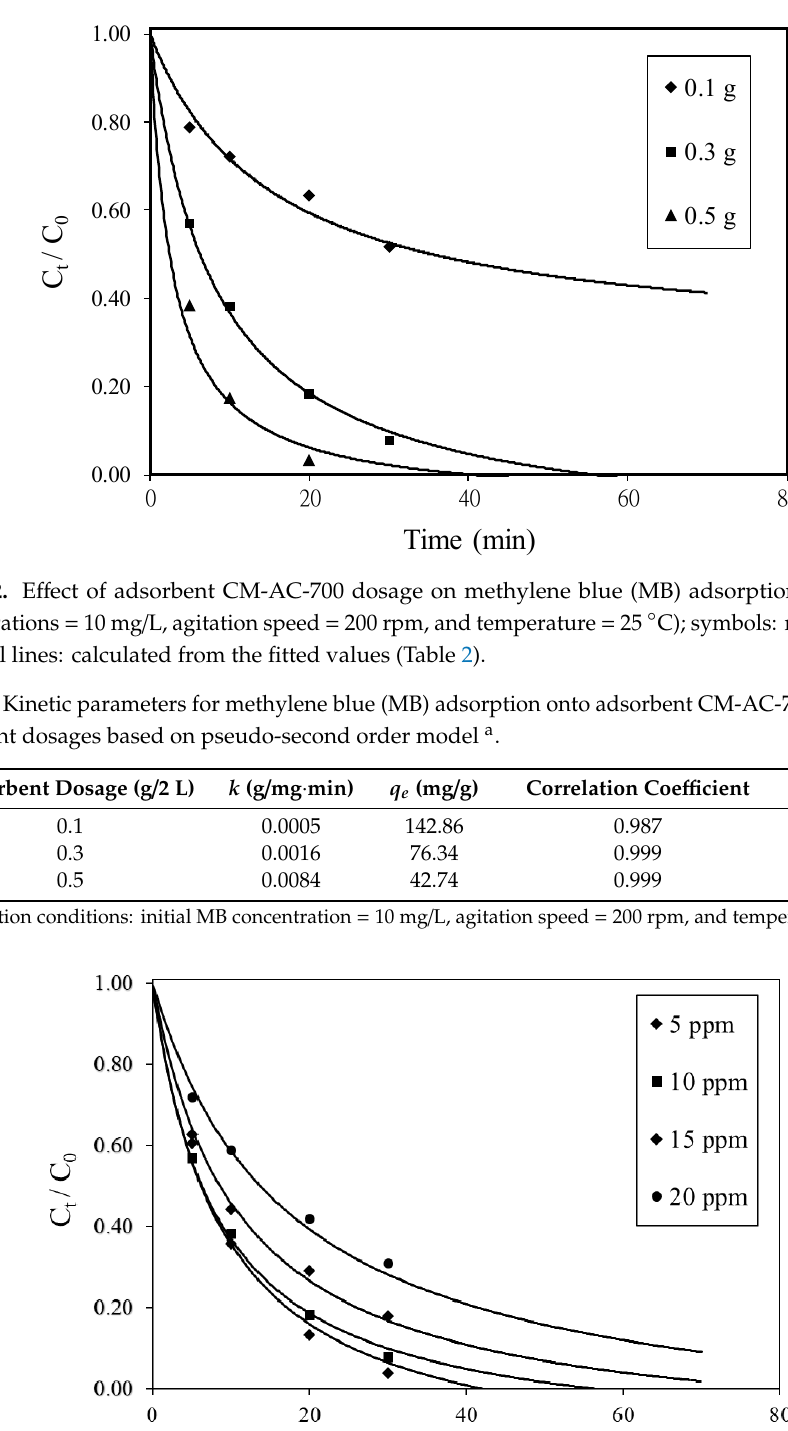
Figure 3. Effect of initial MB concentration on MB adsorption; adsorption conditions: adsorbent CM-AC-700 dosage = 0.3 g/2 L, adsorption temperature = 25 °C, and agitation speed = 200 rpm; symbols: measurement data, full lines: calculated from the fitted values (Table 3).